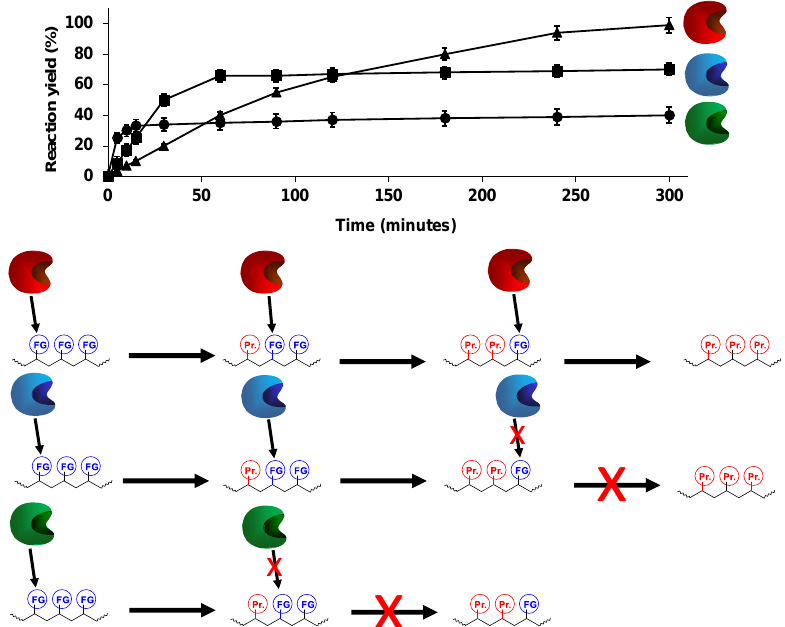
Figure 4. Effect of the enzyme activity (specificity) versus the different intermediate products in the modification of a trifunctional substrate. The figures show the expected reaction courses when a poorly active enzyme is able to recognize all intermediate products, or when the enzymes are unable to recognize some of these intermediate products, even being initially more active versus the initial substrate.